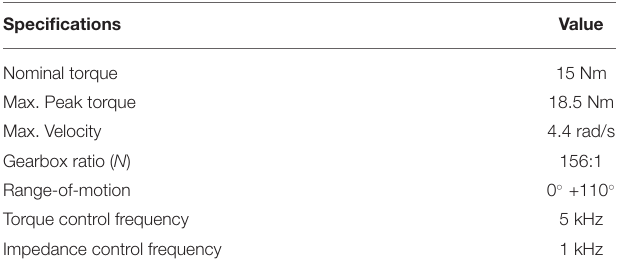
TABLE 2 | The main features and specifications of the developed experimental